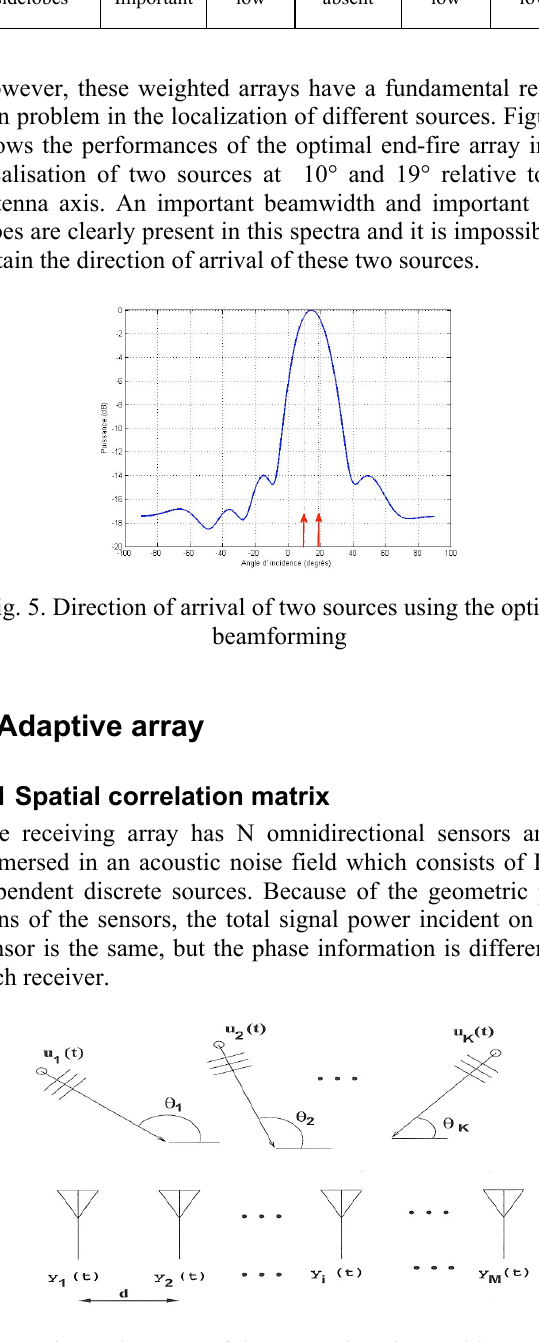
Fig.6. The setup of the source location